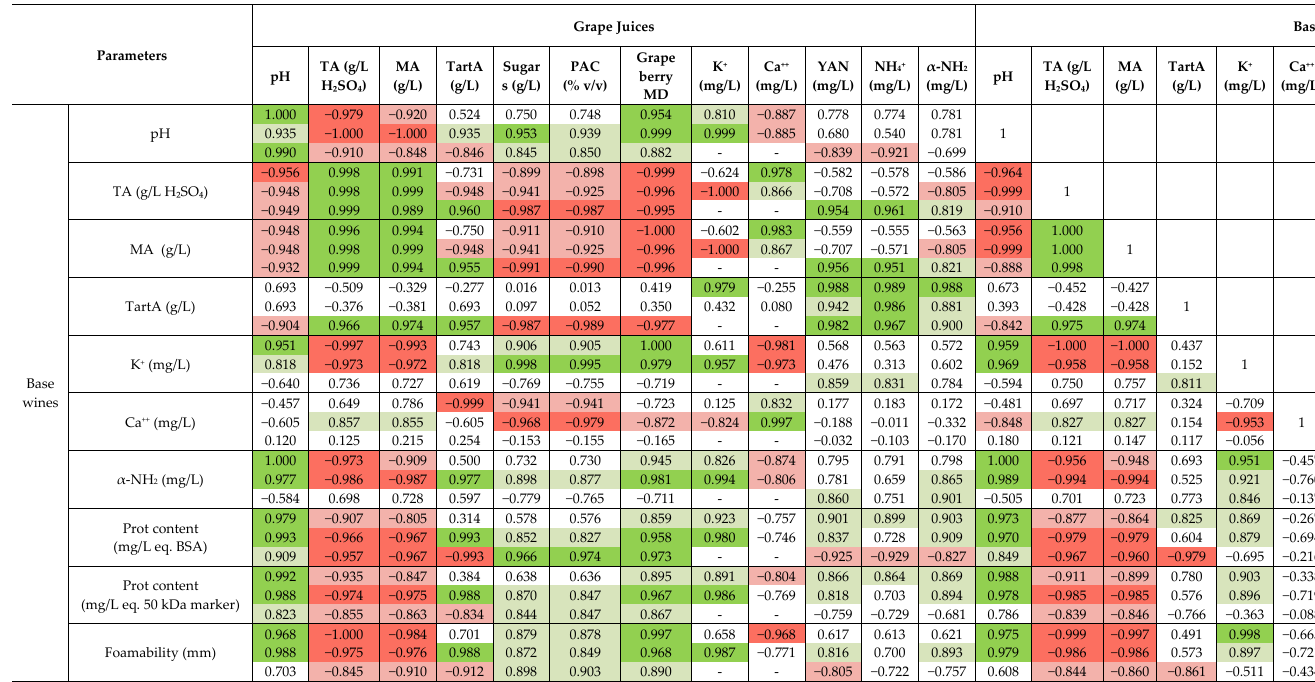
Molecules 2018 , 23 , x FOR PEER REVIEW